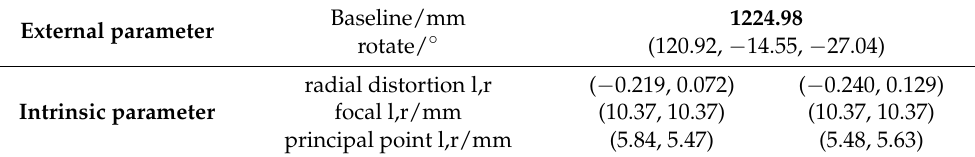
Table 2. Calibration results of the binocular vision.